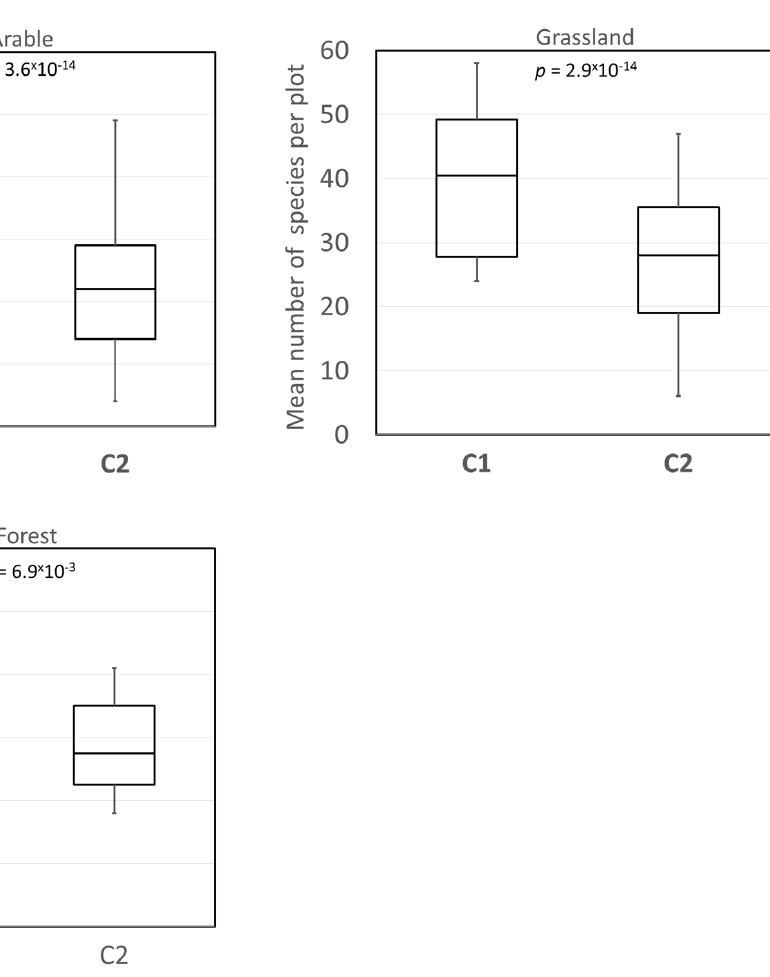
Figure 5. Comparison of species occurrence in the two observation campaigns (C1: 1999–2002; C2: 2013–2015) separated for different habitat types (for details see Tables S8 and S9 in the Supplementary Materials), p of Wilcoxon signed rank test.